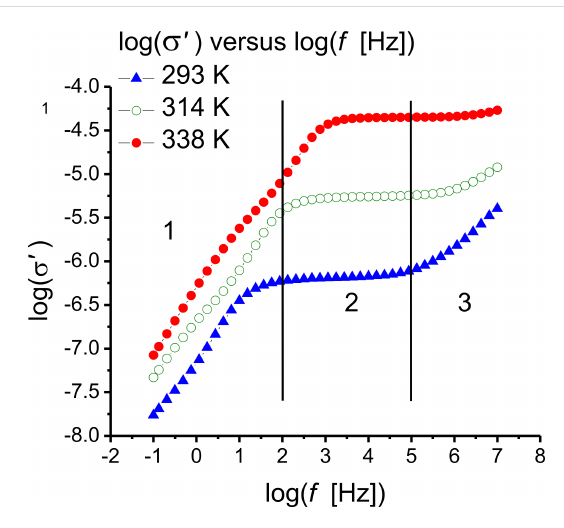
Figure 11: Real part of the conductivity as a function of the frequency (logarithmic scale) for the pure ILC, at three different constant temper- atures. Region 1: low and very low frequency; region 2: medium fre- quency; region 3: high